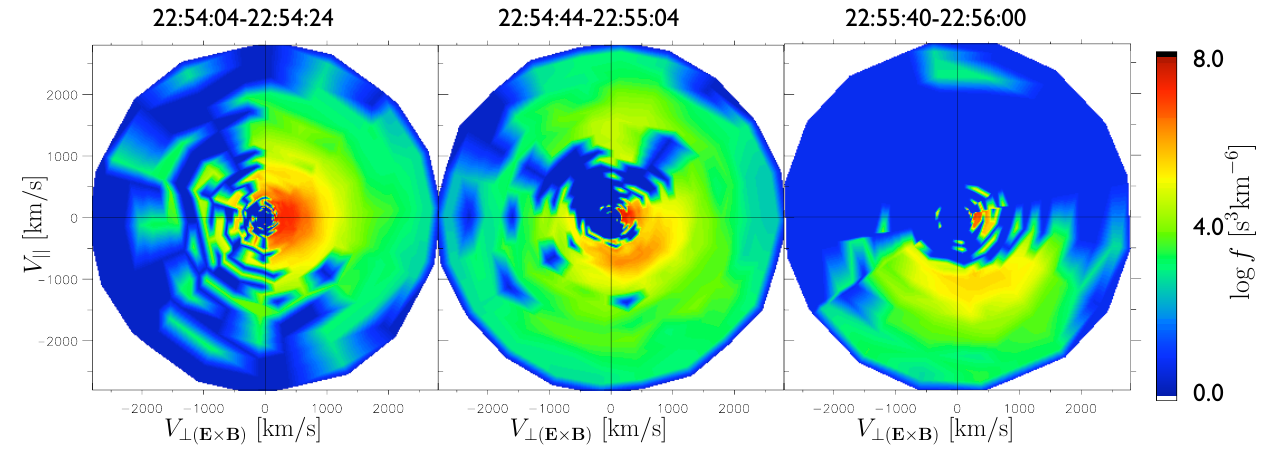
Fig. 7. Proton distributions from CODIF at Cluster 1 for the 3 time intervals shown in Fig. 6a and 6b by three brown